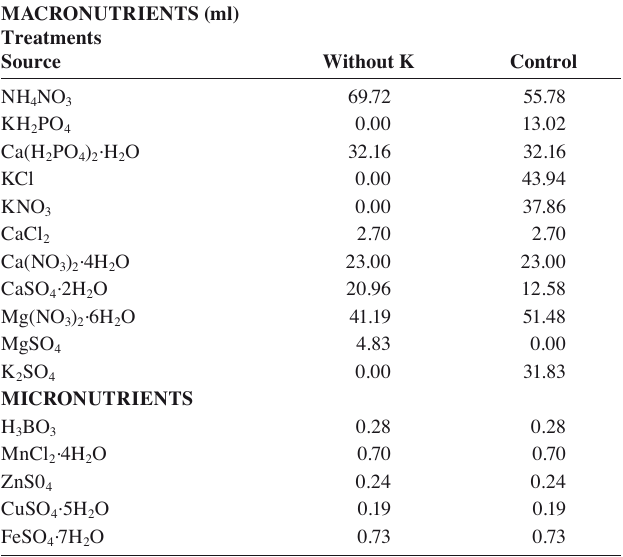
Tab. 1: Concentration of mineral elements (ml of the stock solutions 1 M to be applied to 7.5 L H 2 O) modified based on the stock solutions (H OAGLAND et al., 1938) and the nutrient requirements reported for the species (F ISCHER and M IRANDA ,